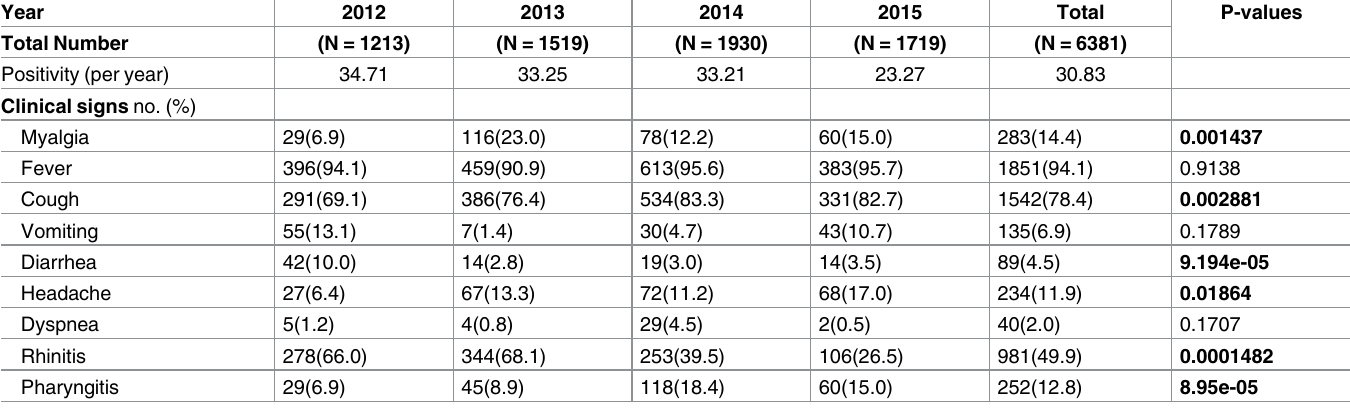
Table 3. Adenoviral infection and clinical signs in patients with ILI in Senegal, 2012–2015.